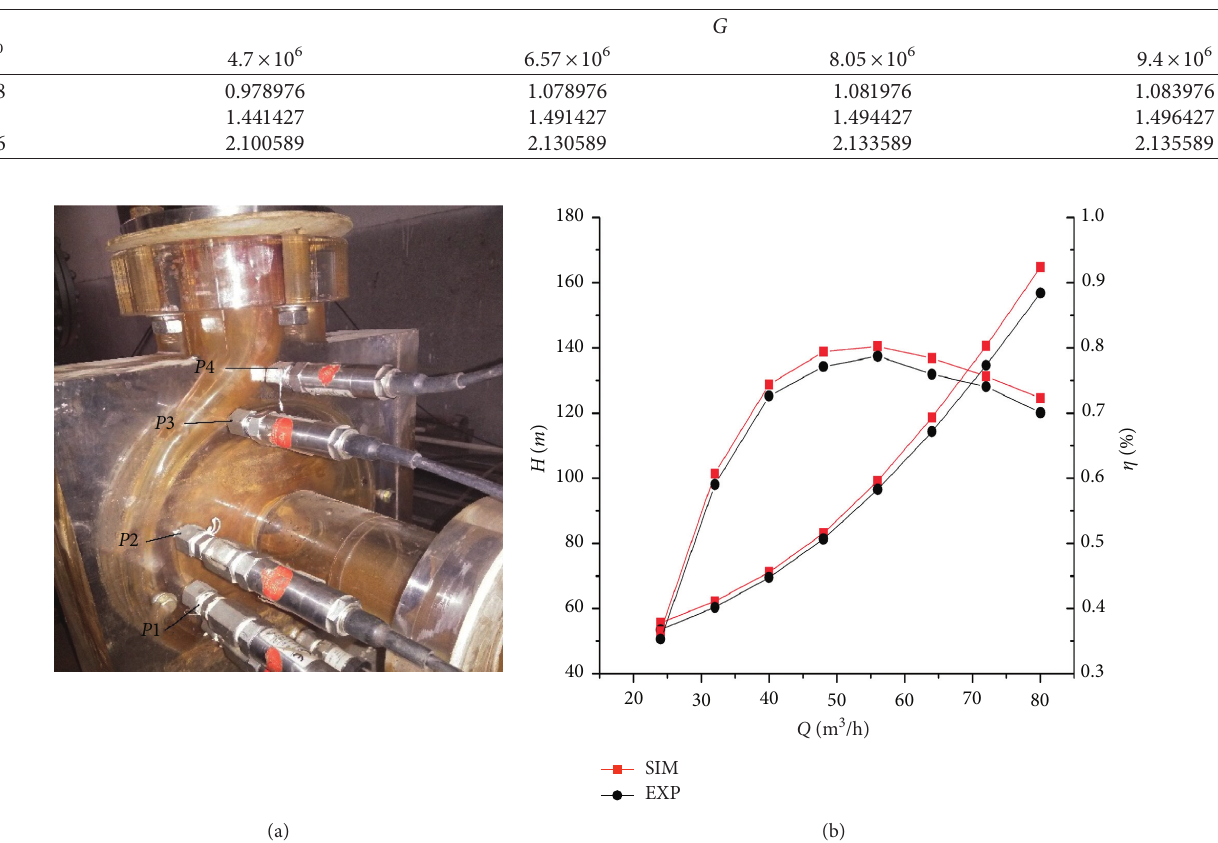
Figure 3: Test rig of model PAT and comparisons of experiments and simulations. (a) Test rig of model PAT. (b) Comparisons of experiments and